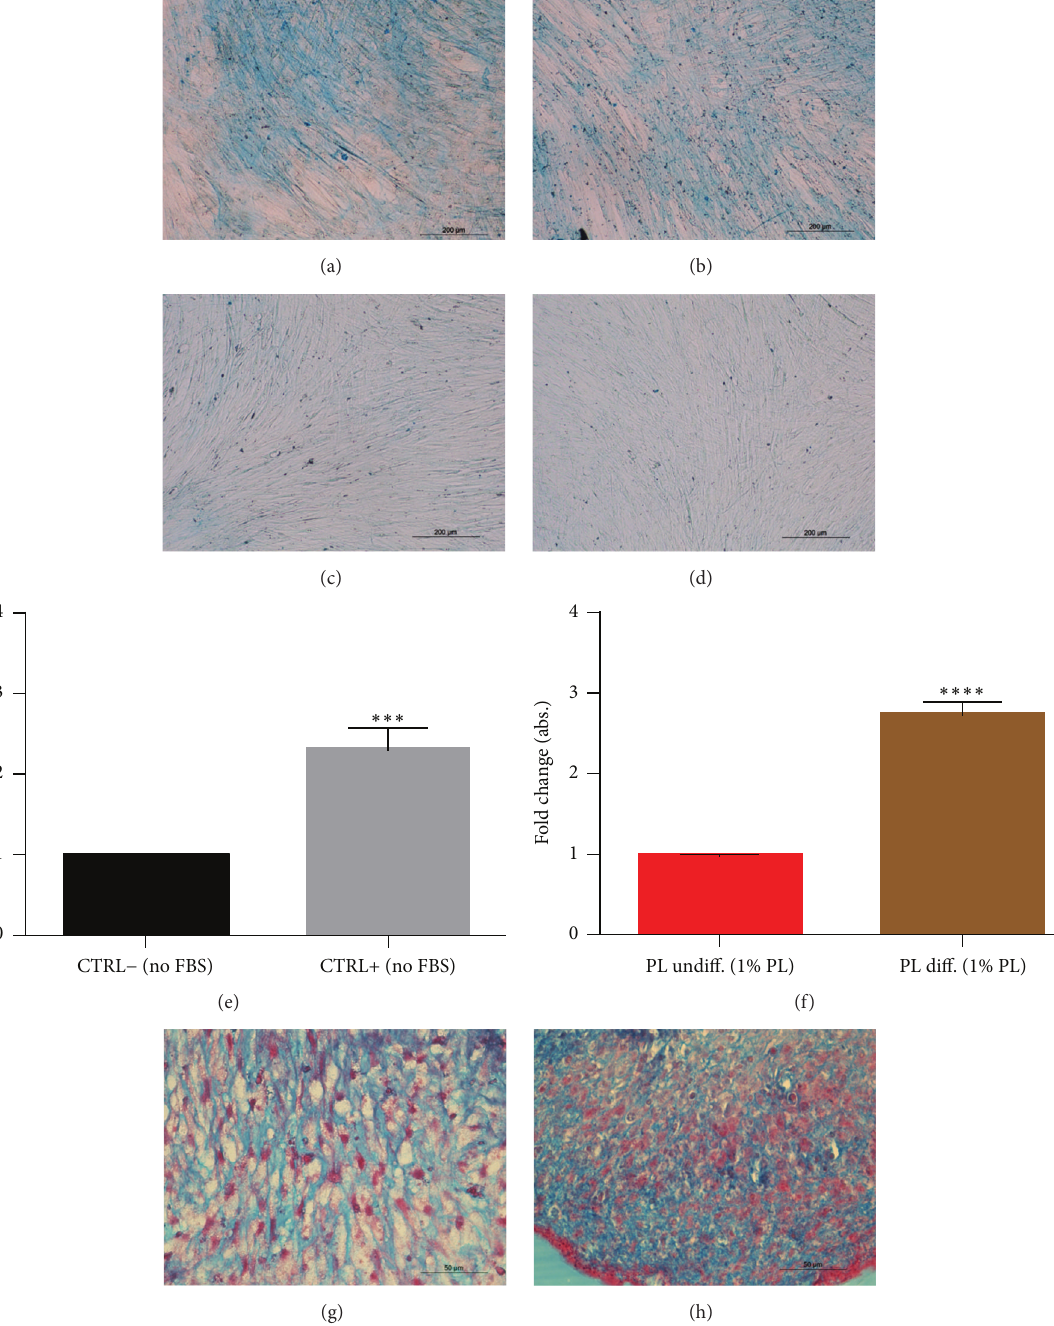
Figure 5: Effect of PL on chondrogenic differentiation of DPSCs. (a–d) Representative images of DPSC cultured for 21 days in chondrogenic medium without (a) or with (b) PL. They were positively stained by Alcian blue, while cells maintained in 10% FBS (c) or 1% PL (d) growth media were not. (e, f) Quantification of Alcian blue by spectrophotometry for assay controls (e) and samples containing PL (f). Significant levels according to unpaired 𝑡 -test ( ∗∗∗ 𝑃 < 0.001 and ∗∗∗∗ 𝑃 < 0.0001 ). Data shown as mean + SD, obtained from three experiments. (g, h) Micromass culture of DPSCs showing positive histological staining for chondrogenesis for control (g) as well as the micromasses cultured with differentiating medium with 1% PL